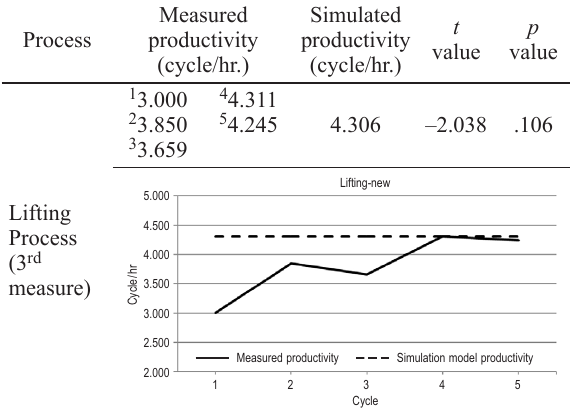
t p value value